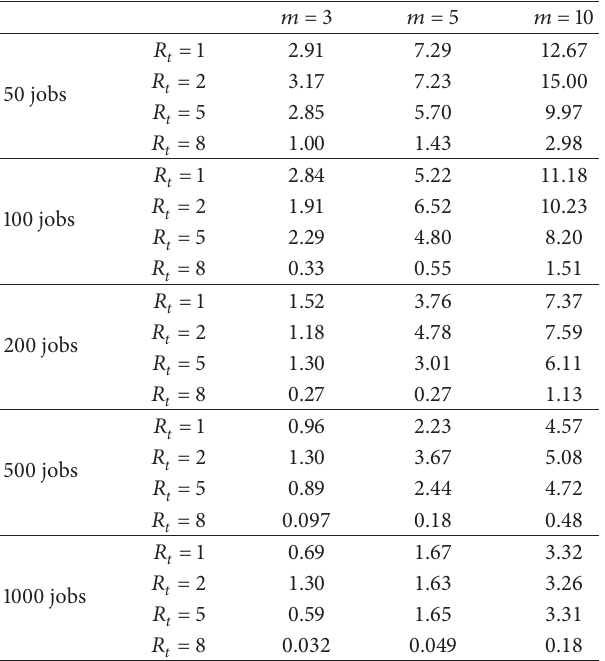
Table 6: Asymptotic performance tests for MGS (normal distribu- tion